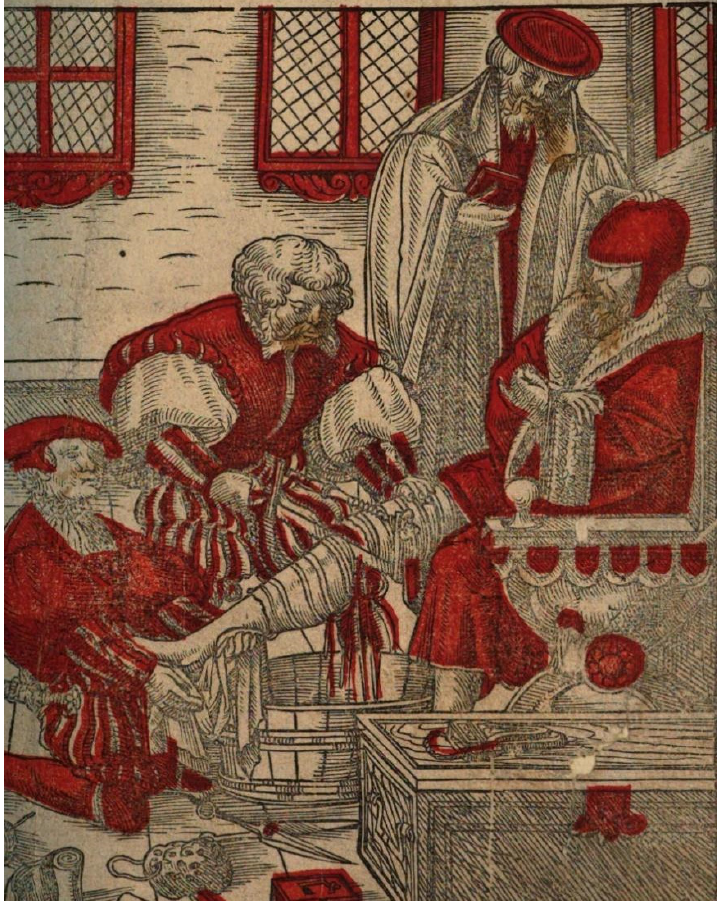
Figure 3. Surgical tools including an instrument case (far right). Hieronymus Brunschwig, Buch der Cirurgia (Strasbourg: Johann Grüninger, 1497), fo. 17r. Munich, Bayerische Staatsbibliothek—2 Inc.c.a. 3452 .